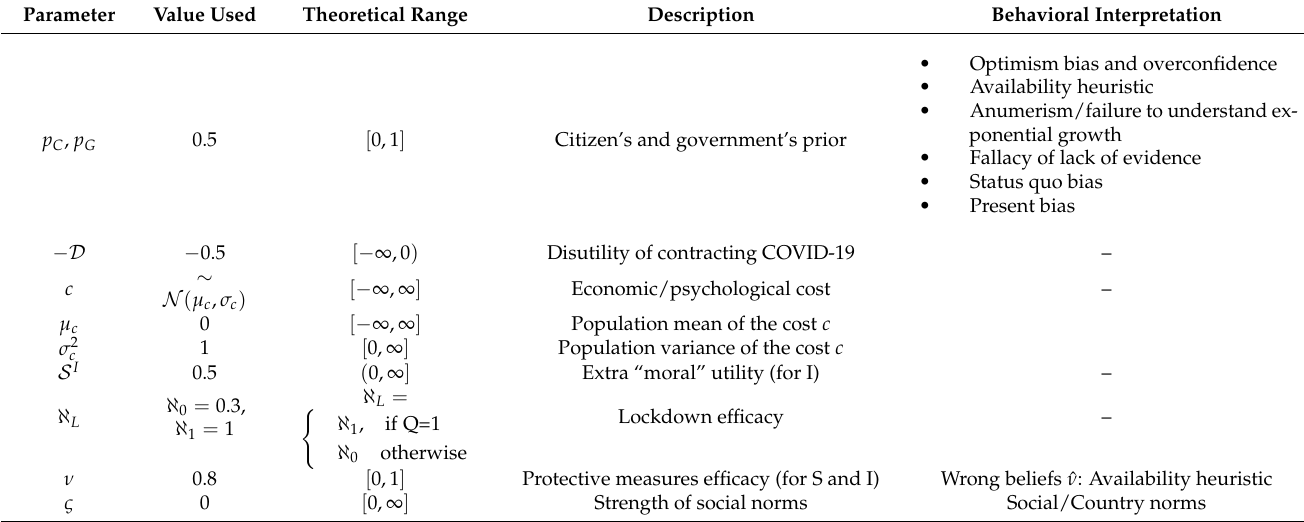
Table 2. Relevant Behavioral and Economic